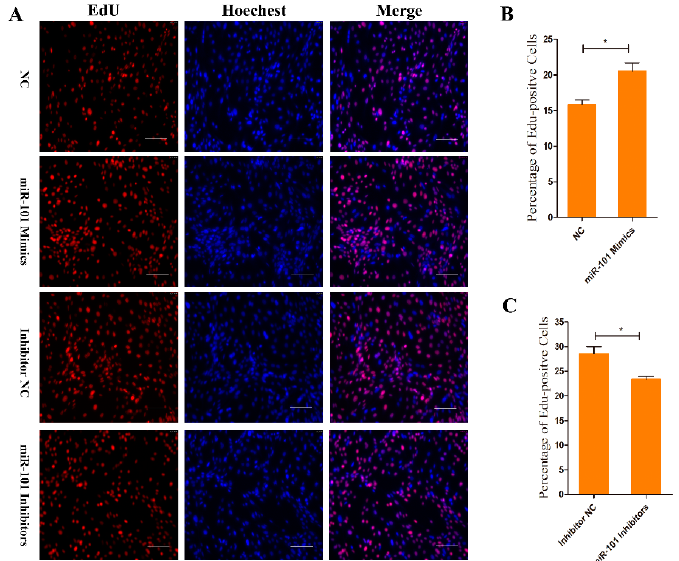
Figure 2. EdU assay of HFSCs proliferation after transfection with NC, goat miR-101 mimics, inhibitor NC and goat miR-101 inhibitors: ( A ) Representative images after EdU assay of HFSCs at 24 h after transfection with NC, goat miR-101 mimics, inhibitor NC and goat miR-101 inhibitors. Bars = 100 µ m; ( B , C ) Quantification of EdU-positive cells. The proportion of EdU-positive cells was calculated as (EdU-positive cells/Hoechst-stained cells) × 100%. No asterisk, p > 0.05; *, p < 0.05.